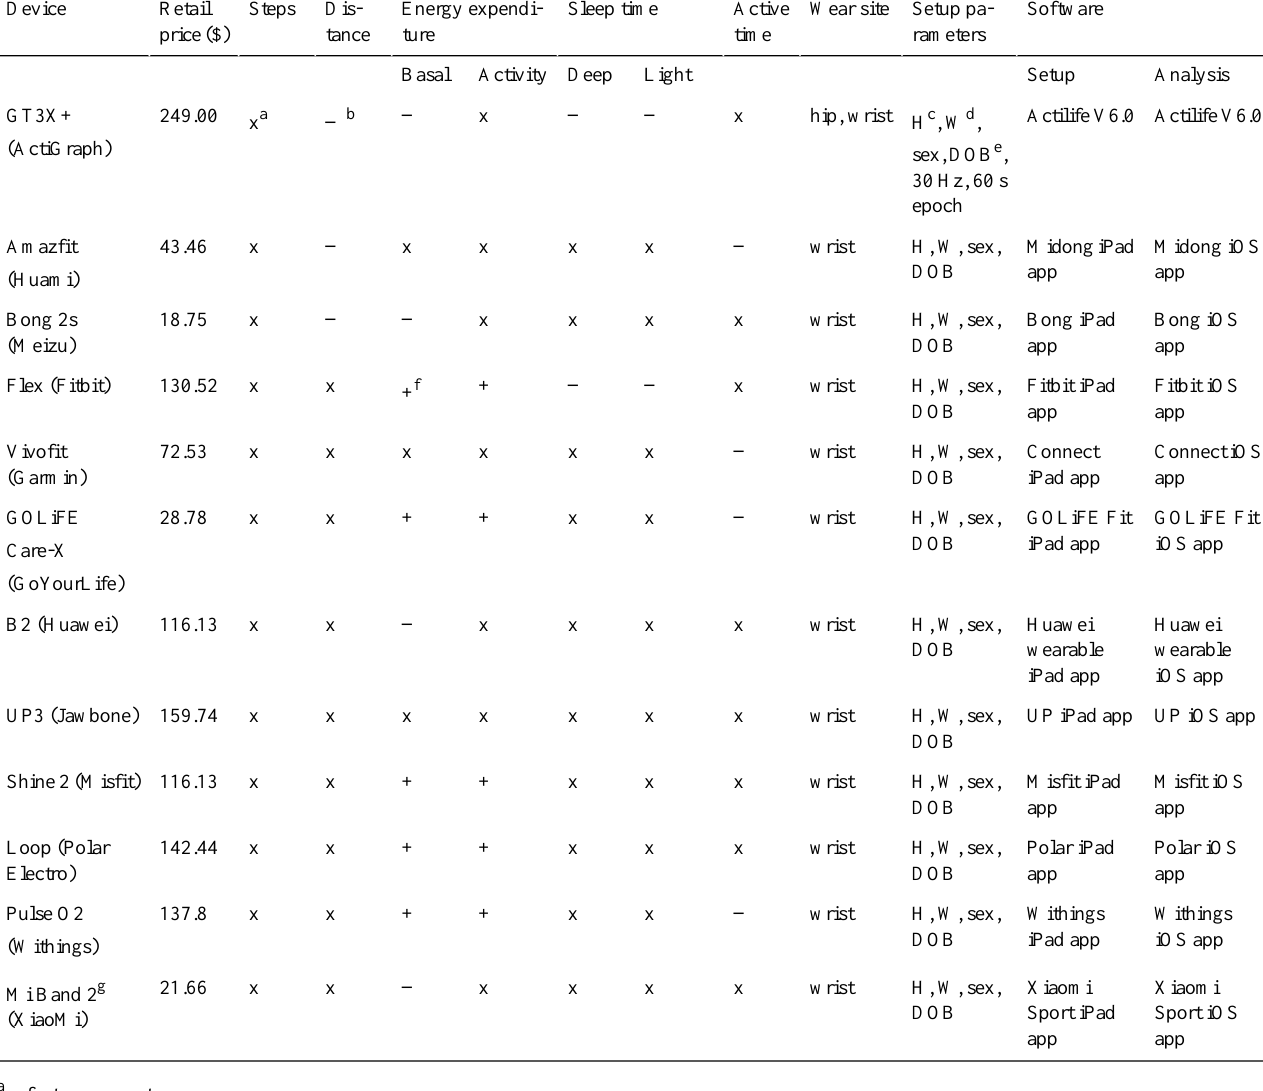
Table 1. Activity devices details, set up parameters and analysis software.